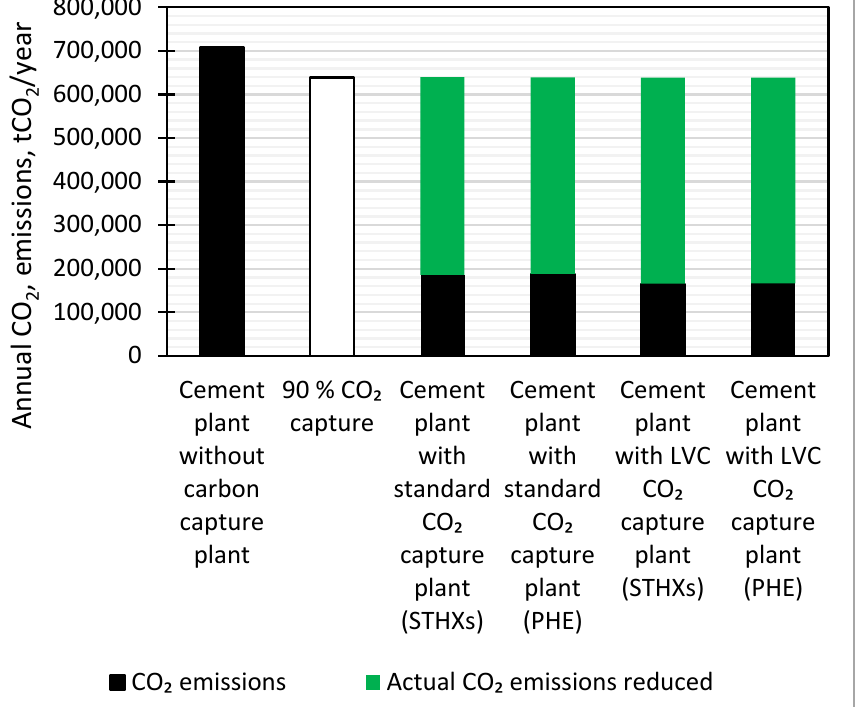
Figure 6. Annual CO 2 emissions reduction analysis.